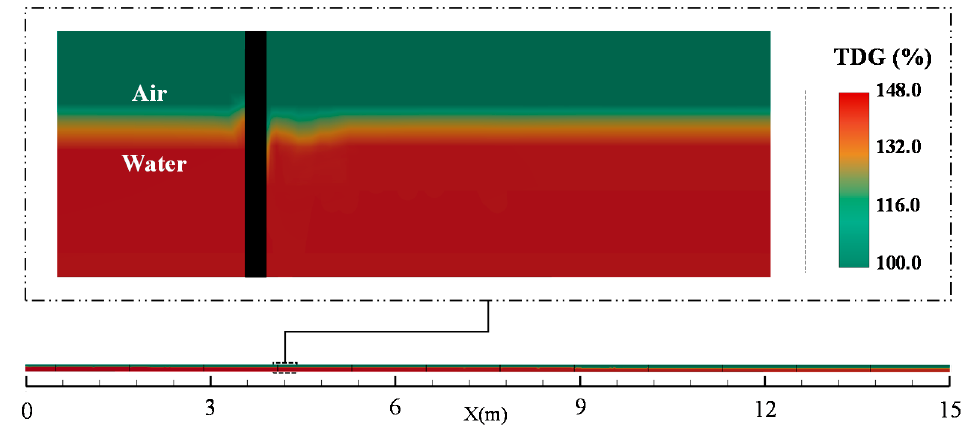
Figure 12. Vertical distribution of supersaturated TDG (Case 25).